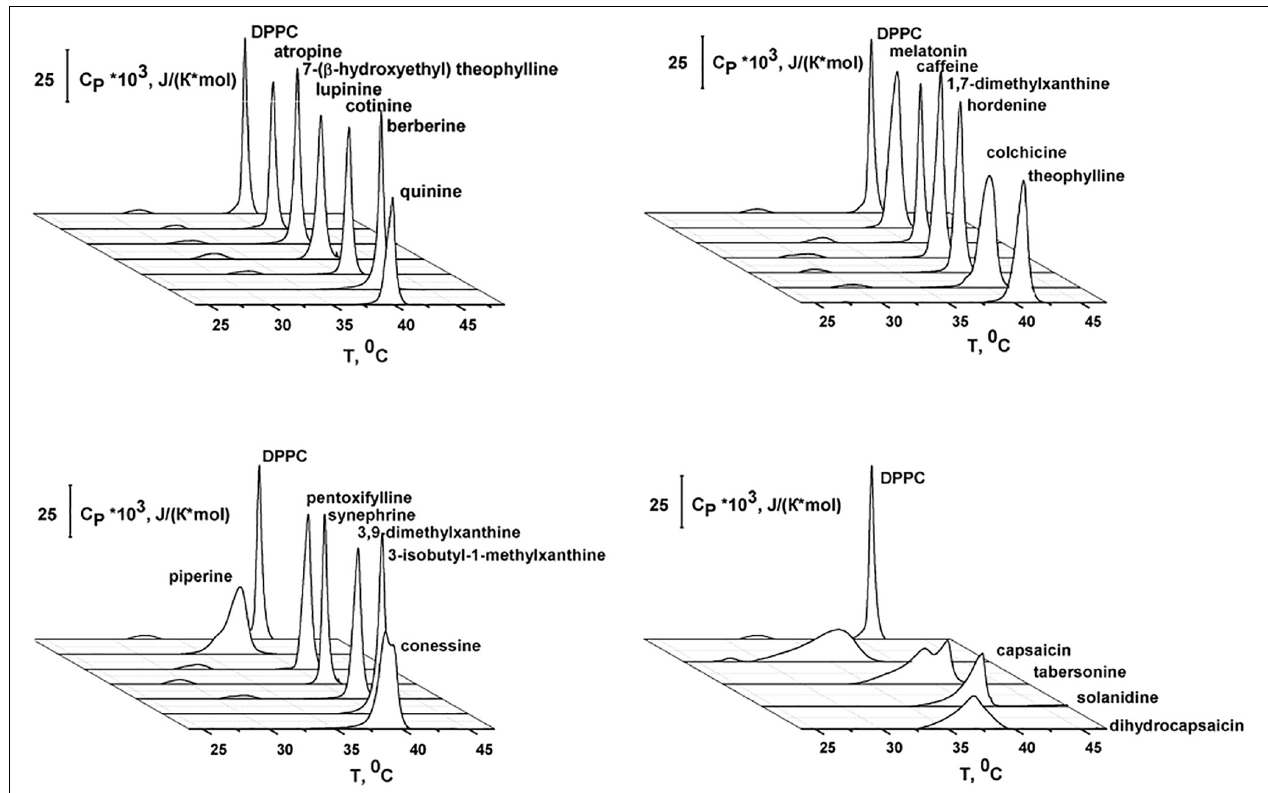
FIGURE 3 | Heating DSC thermograms of DPPC liposomes in the absence ( control ) and presence of different alkaloids at the lipid:agent molar ratio of